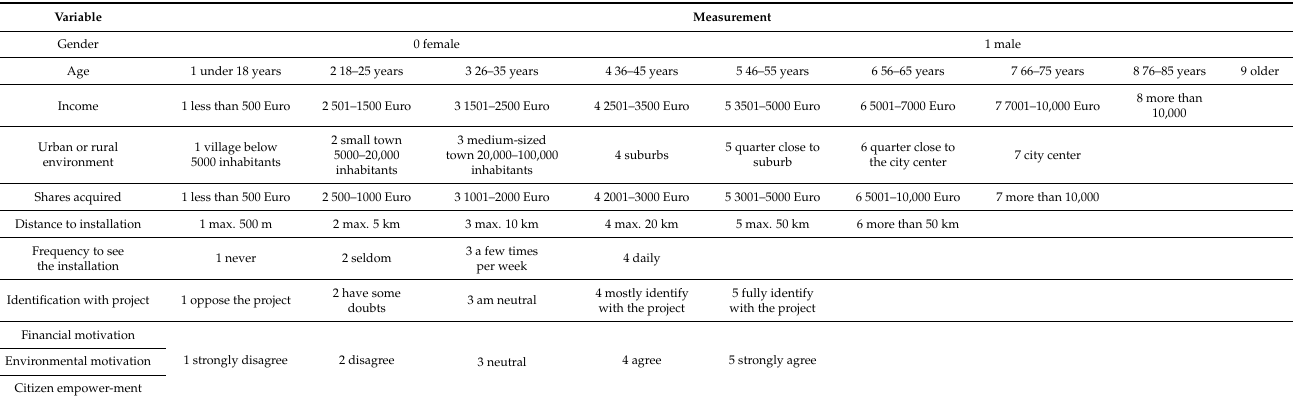
Table A1. Overview of all variables and their respective level of